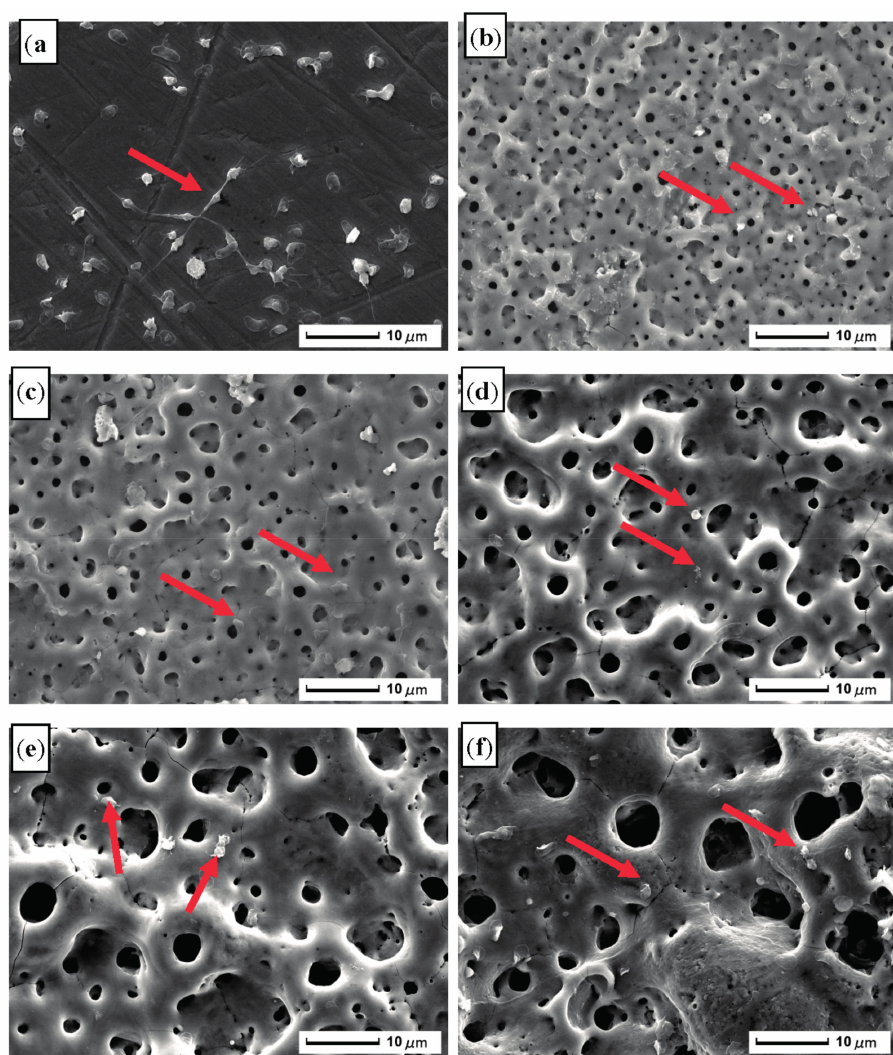
Figure 12. SEM images of the adhesion deformation of platelets on the sample surfaces: ( a ) E00: substrate; ( b ) E03: 3 min; ( c ) E06: 6 min; ( d ) E09: 9 min; ( e ) E12: 12 min; and ( f ) E15: 15